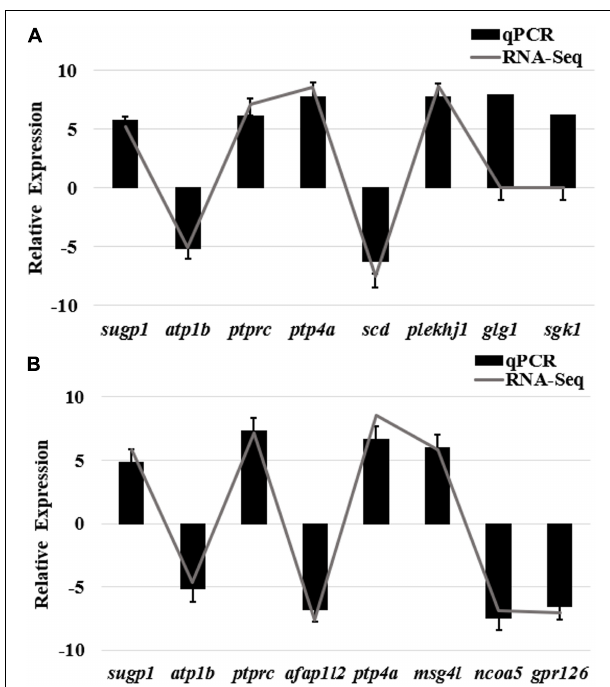
FIGURE 7 | qRT-PCR validation of differently expressed genes in bone tissues of bighead carp from differential growth groups. (A) qRT-PCR validation of differently expressed genes of frontal and parietal bones between big and small groups of bighead carp. (B) qRT-PCR validation of differently expressed genes of vertebral bones between big and small groups of bighead carp. Gene expressions were expressed as mean normalized ratios ( n = 3, ± SE). β -Actin was used as reference gene. Positive values denote up-regulation in big group compared to small group of bighead carp. Gene abbreviations: SURP and G-patch domain-containing protein 1 ( sugp1 ), sodium/potassium-transporting ATPase subunit β ( atp1b ), receptor-type tyrosine-protein phosphatase C ( ptprc ), protein tyrosine phosphatase type IVA ( ptp4a ), stearoyl-CoA desaturase ( scd ), pleckstrin homology domain-containing family J member 1 ( plekhj1 ), actin filament–associated protein 1-like 2 ( afap1l2 ), microfibril-associated glycoprotein 4-like ( msg4l ), nuclear receptor co-activator 5 ( ncoa5 ), golgi apparatus protein 1 ( glg1 ), G-protein coupled receptor 126( gpr126 ), serine/threonine-protein kinase Sgk1( sgk1